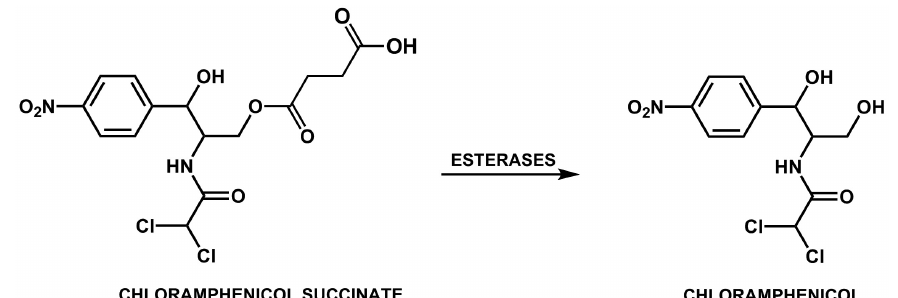
FIGURE 24 - Bioactivation of chloramphenicol succinate.